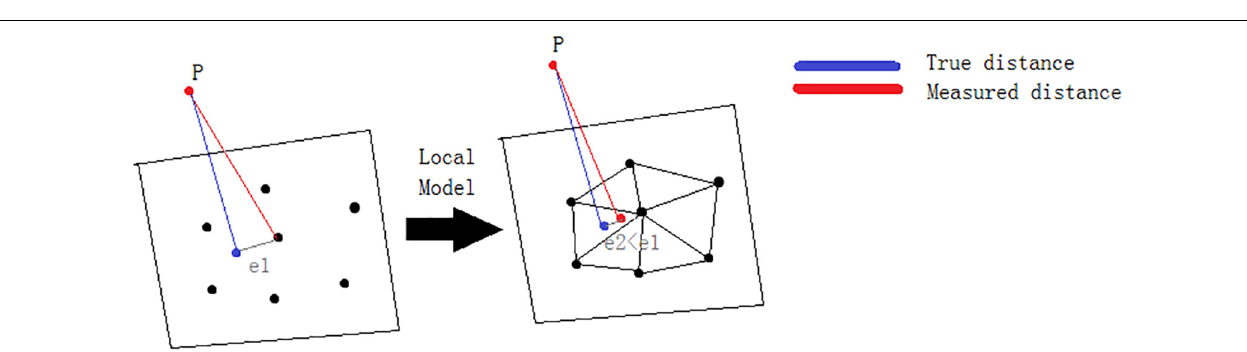
FIGURE 5 | Register the two metal crown models before 3D measurement using the ICP algorithm. (A) Standard metal crown model; (B) Scanned metal crown model; (C) Registered metal crown models.